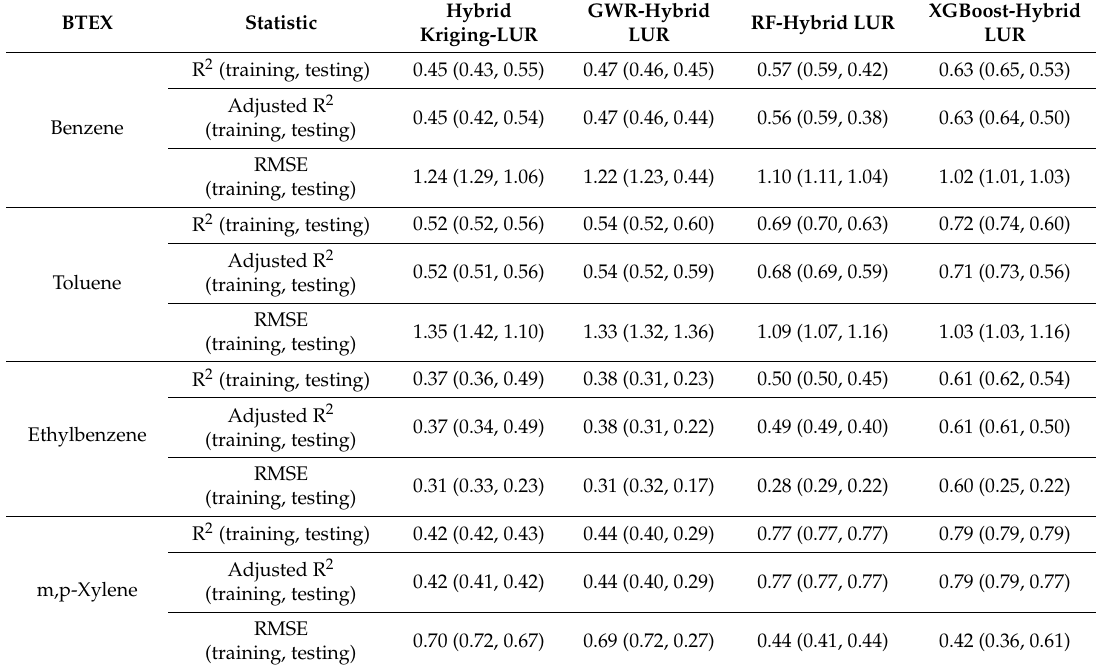
Table 2. Performance of the Hybrid Kriging-LUR, GWR-Hybrid LUR, RF-Hybrid LUR and XGBoost- Hybrid LUR models. GWR—geographically weighted regression; LUR—Land-use regression; RF—random forest; XGBoost—extreme gradient boosting; RMSE—root mean square